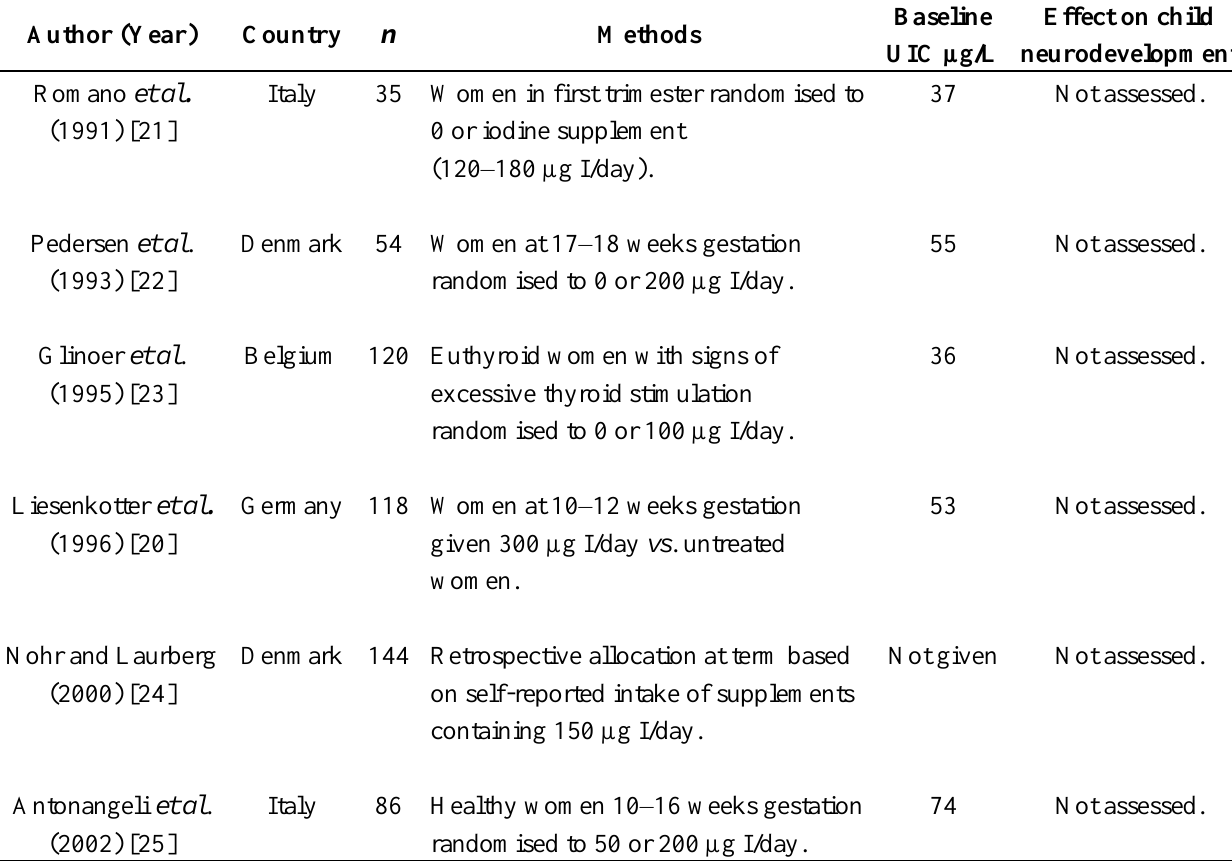
Table 1. Studies investigating the effect of iodine supplementation in